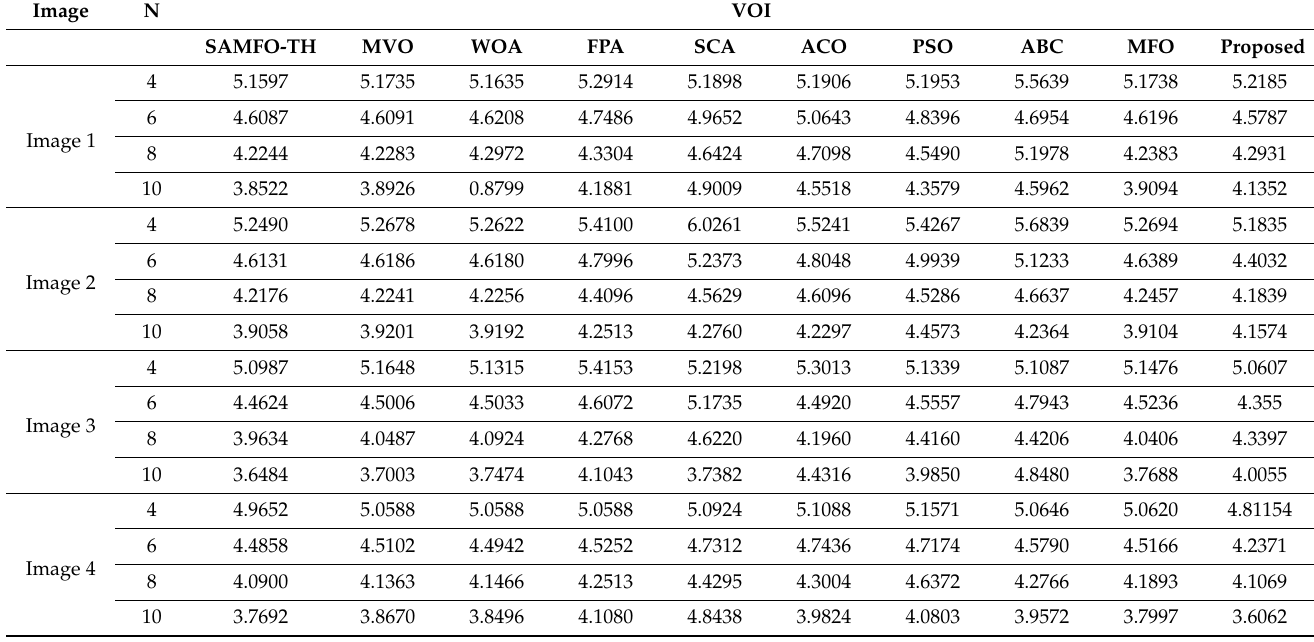
Table 14. Comparison of VOI computed by SAMFO-TH, MVO, WOA, FPA, SCA, ACO, PSO, ABC, and MFO with the proposed model using Otsu’s method with N = 4, 6, 8, and